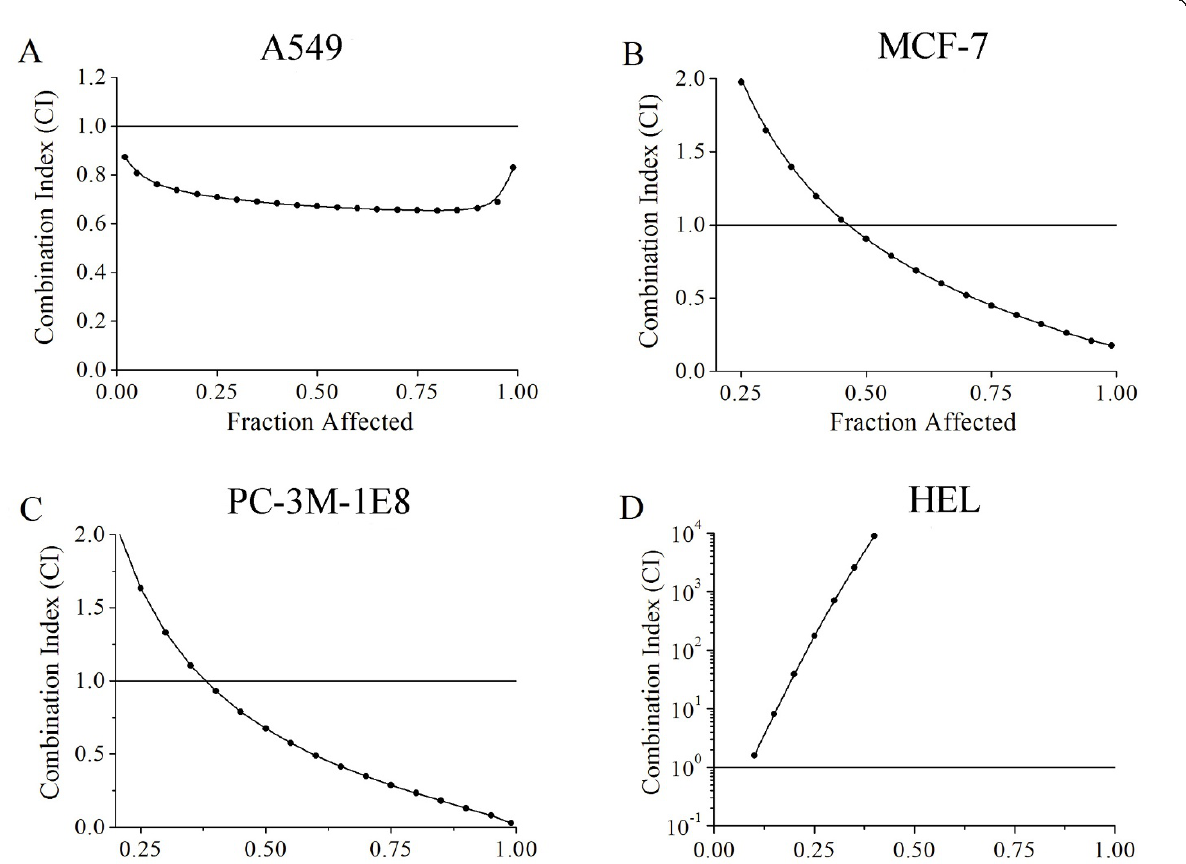
Figure 6 Synergistic antitumor effect of the combination of TC extract and 5-FU in vitro . Combination index (CI) of TC extract with 5-FU in human lung cancer cell line A549 (A), human breast cancer cell line MCF-7 (B), human prostate cancer cell line PC-3M-1E8 (C), and human embryo lung cell line HEL (D) was calculated as described. Here, Fraction Affected on the x-axis denotes the proportion of cells affected (e.g., a Fraction Affected of 0.5 is equivalent to a 50% reduction in cell